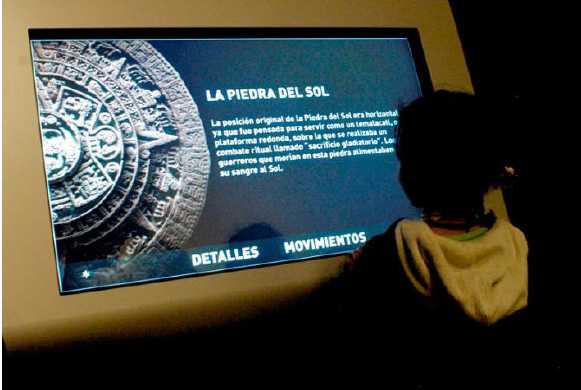
Figure 15 . Digital technologies for the dissemination of cultural Heritage. Details and movements: Piedra del Sol. © Conacyt Agencia